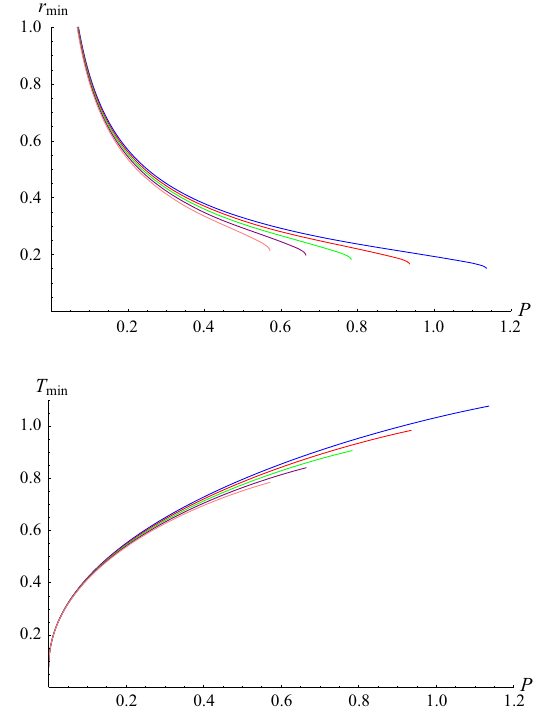
Fig. 7 Plots of the radius r max (top left), the radius r min (top right), the temperature T max (bottom left) and the temperature T min (bottom right) in terms of the pressure for the different values of the characteristic